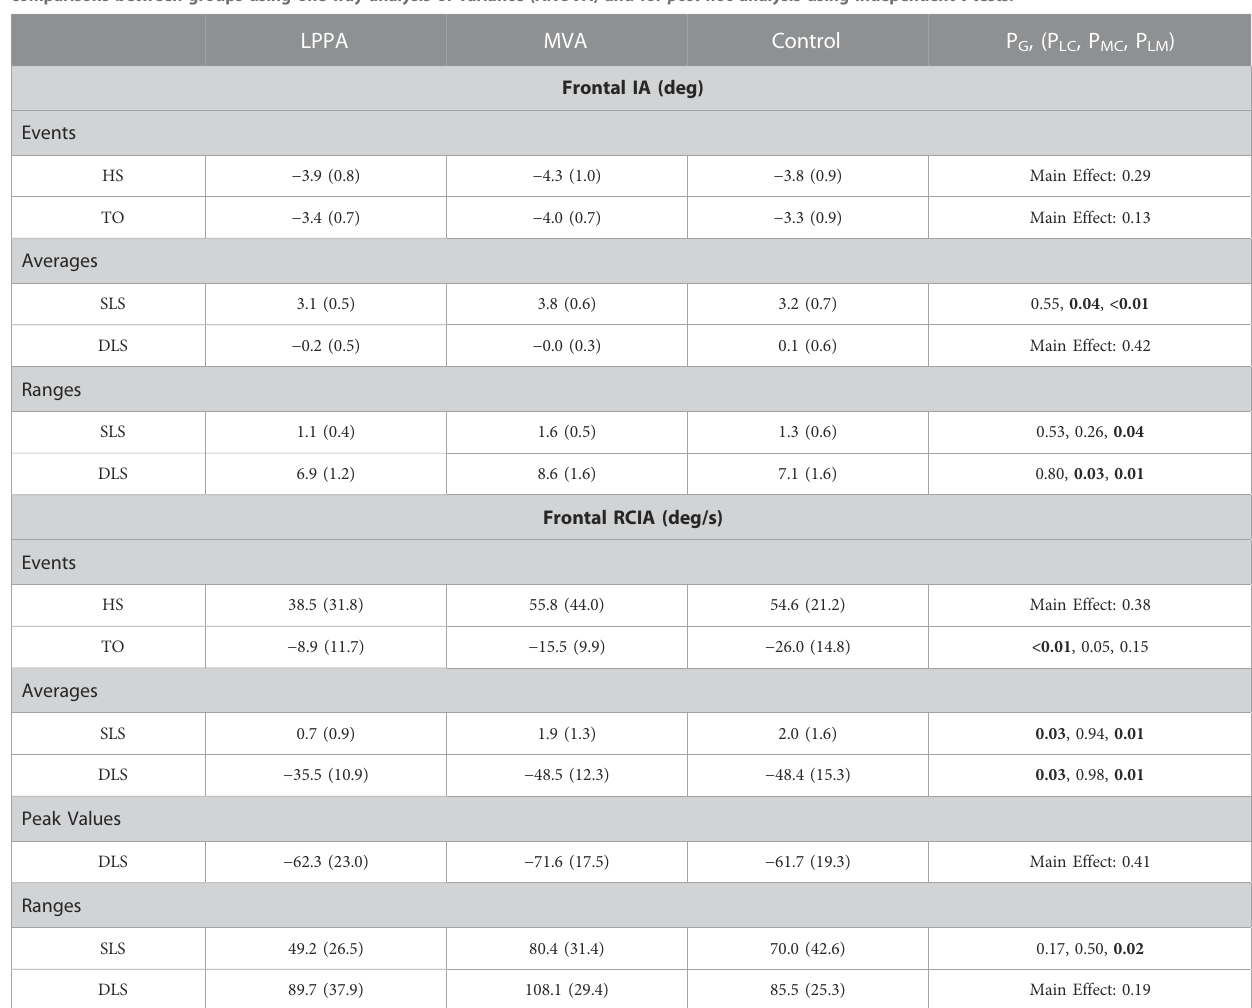
TABLE 3 Means (standard deviations) of inclination angles (IA) and rates of change of IA (RCIA) in the frontal plane at heel-strike (HS) and toe-off (TO), and their average values and ranges during double-limb support (DLS) and single-limb support (SLS), as well as peak RCIA during DLS. p -values are also given for comparisons between groups using one-way analysis of variance (ANOVA) and for post hoc analysis using independent t